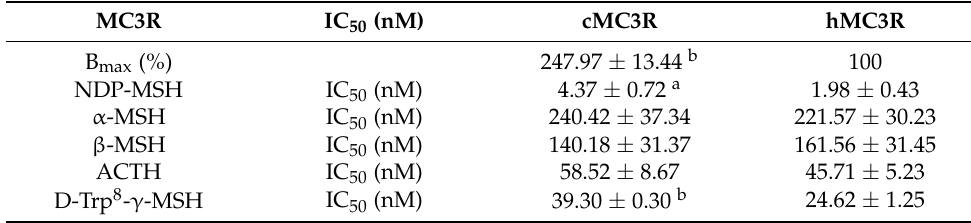
Table 1. The ligand binding properties of